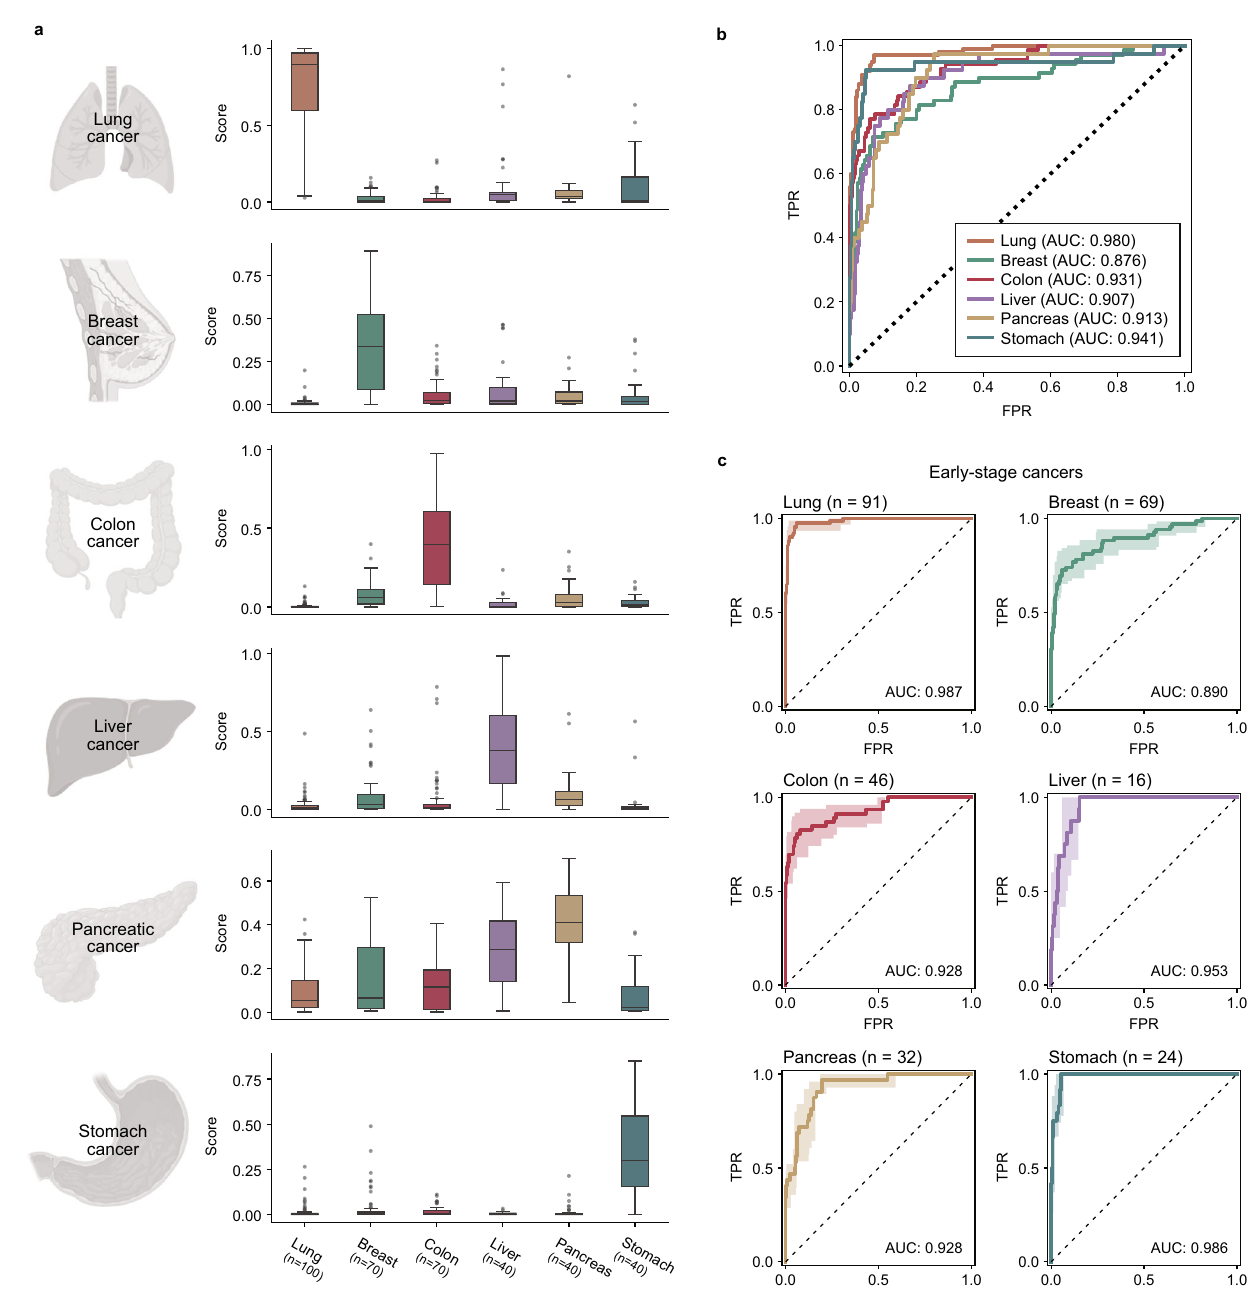
Fig. 4 | Tissue of Origin (TOO) discrimination. a Diagnostic score tendency for each cancer typefortestsamples. The box plot presentsthe median, inter-quartile range (Q1 and Q3), min – max range, and outliers. Bars represent standard errors. b ROC curves showing classi fi cation performance for the entire test sample. AUCs are shown in each graph. c Classi fi cation ofearly-cancer cases. Lung, breast, colon,